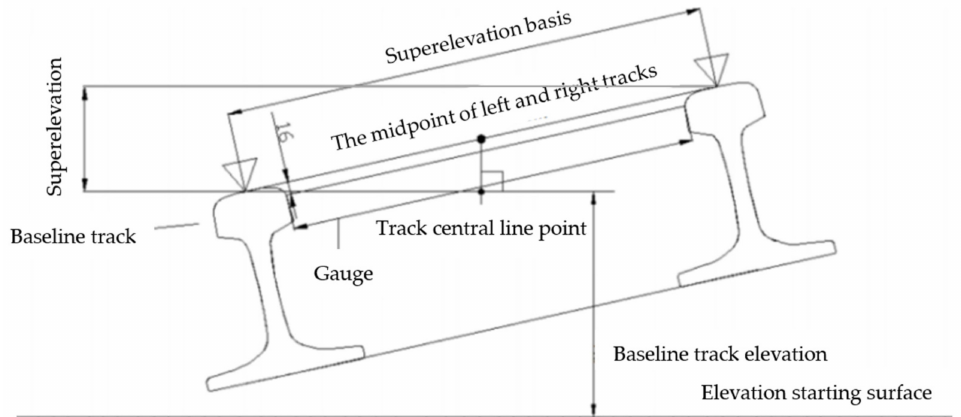
Figure 9. Schematic diagram of the track geometric